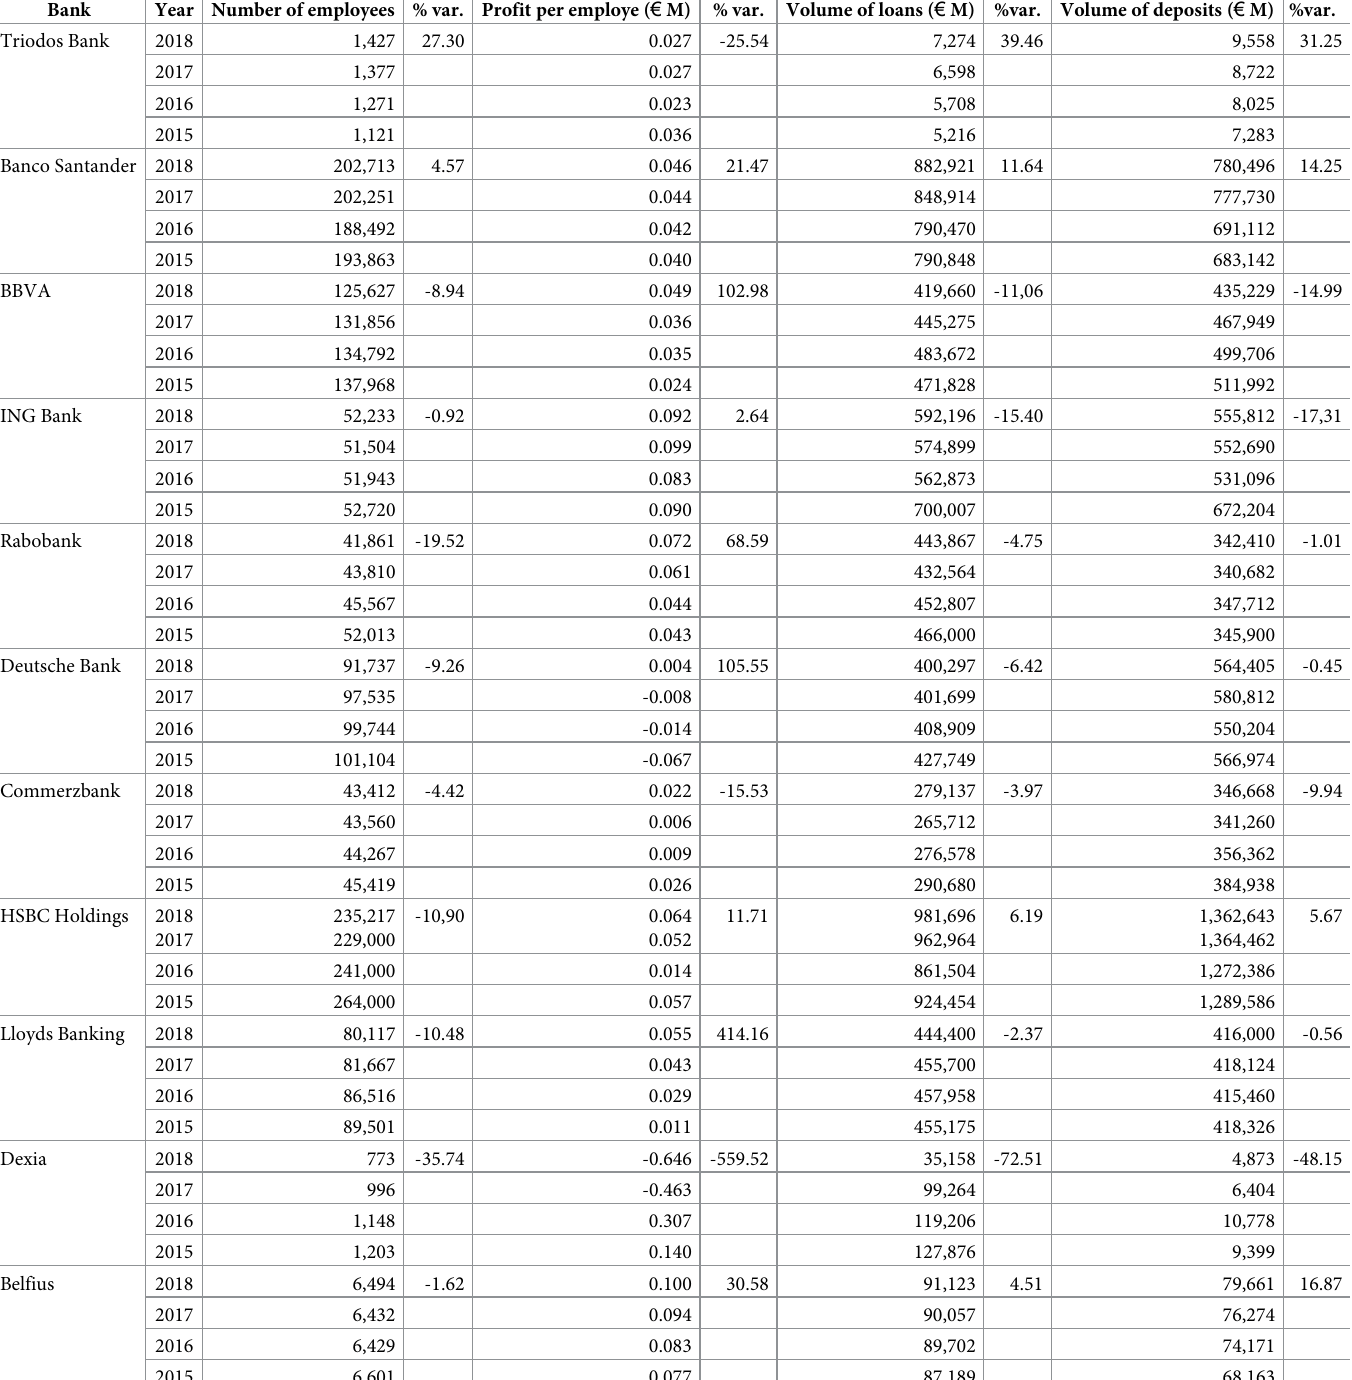
Table 3. Comparison of the number of employees, profit per employee, volume of loans and deposits.